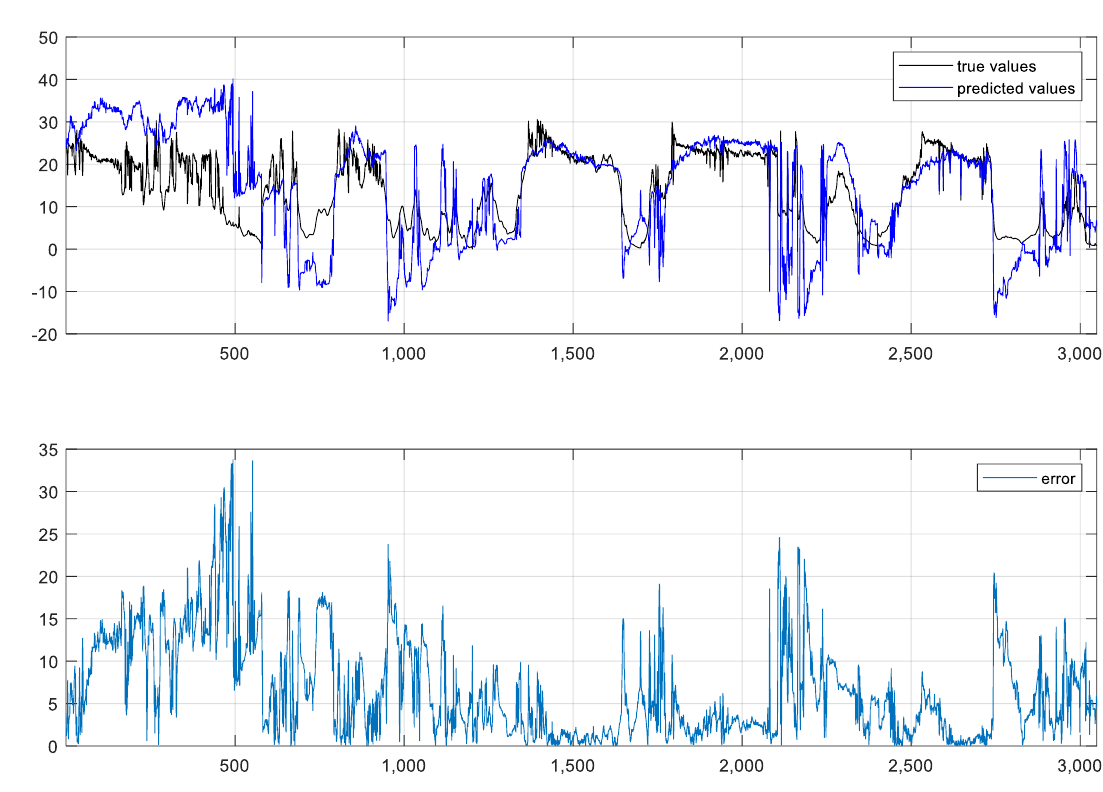
Figure 9. Results of ABC – ANN for testing part.